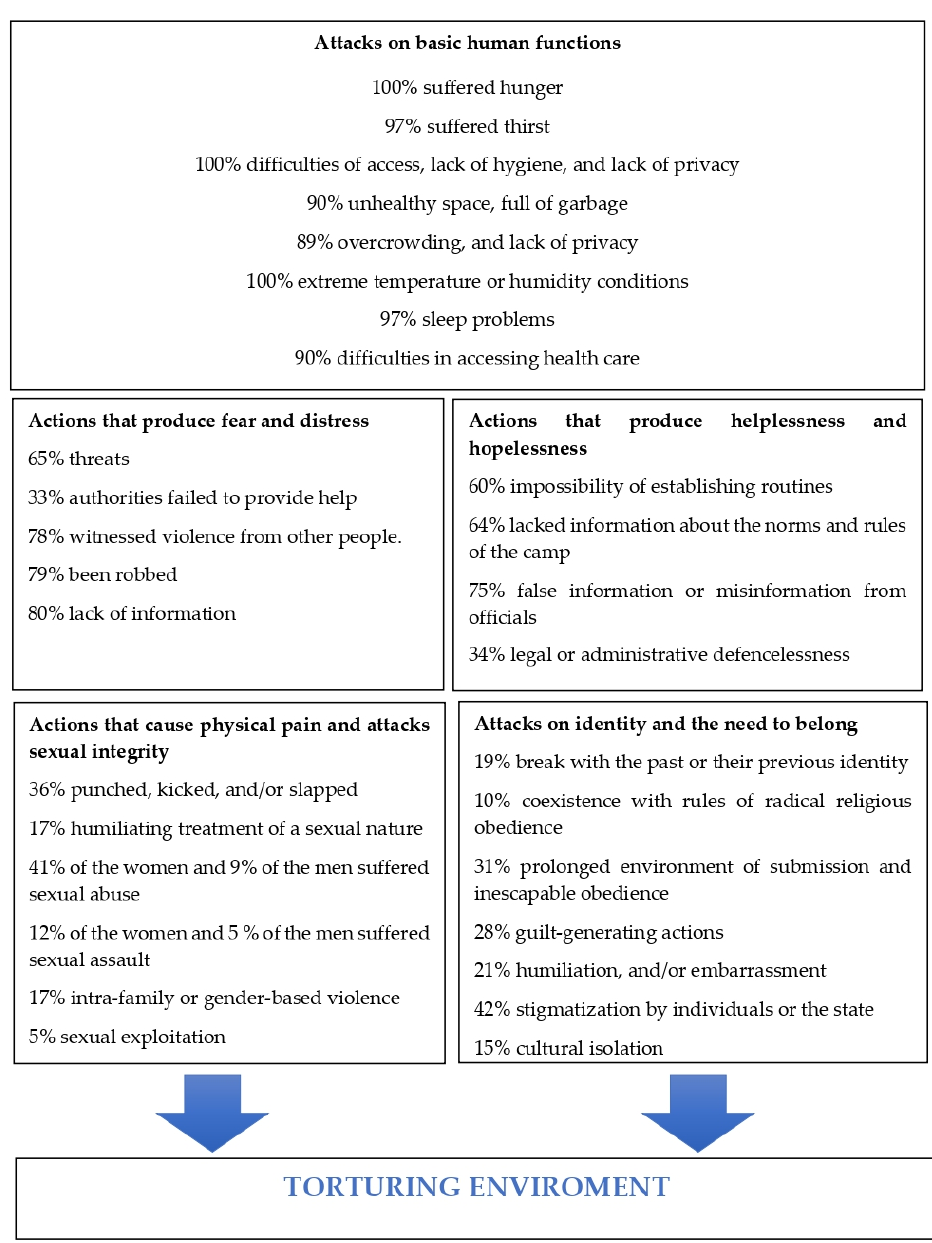
Figure 1. Main findings of the research.